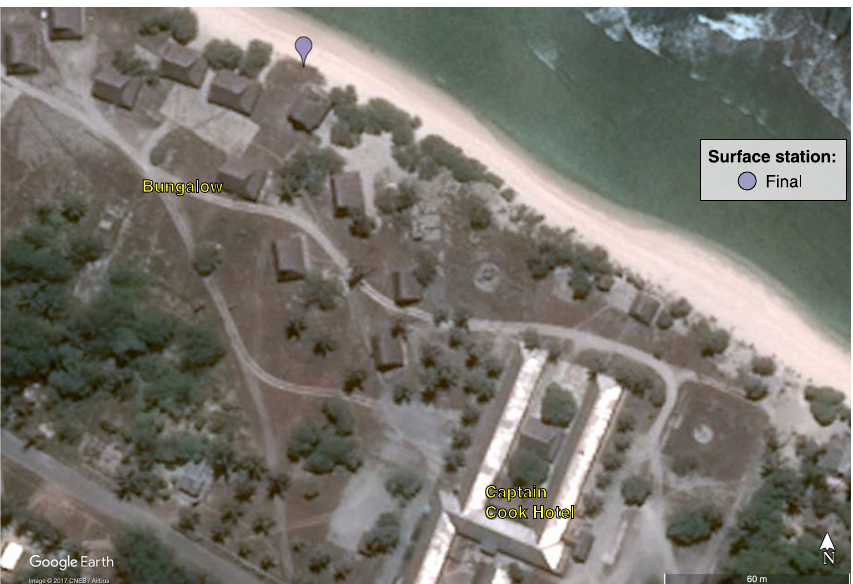
Figure 2. Aerial view of the Captain Cook Hotel property on Kiritimati, including the CXENRR site (upper left). The final location of the surface meteorology instruments is at the base of the pin symbol, north-northeast of the bungalow that housed staff and the Vaisala DigiCORA sounding system. The concrete pad where the helium tanks were stored and from which balloons were launched runs northwest to southeast, ending just north of the bungalow. The main hotel building used for Internet access is southeast of the CXENRR site.